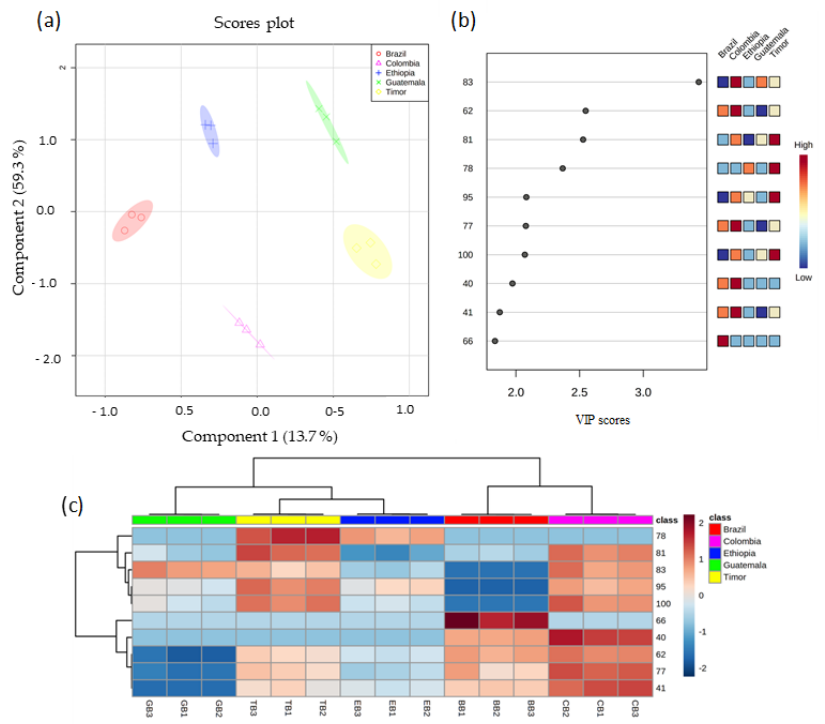
Figure 5. PLS-DA of the volatile fingerprint of spent coffee grounds from different geographical origins ( a ) score scatter plot, and ( b ) VIP scores and ( c ) hierarchical cluster analysis (HCA). (Attribution of the peak number is shown in Table 1).